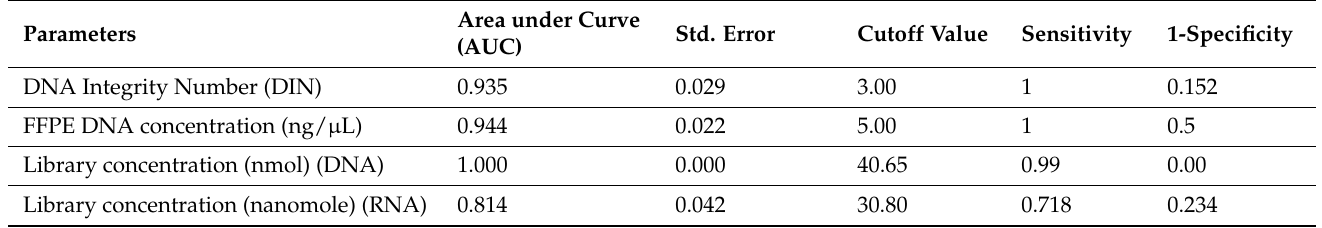
Table 5 The pre-analytical parameters are DIN and FFPE DNA concentration. Post-analytical parameters consist of the library concentration (nanomole) of DNA and RNA.